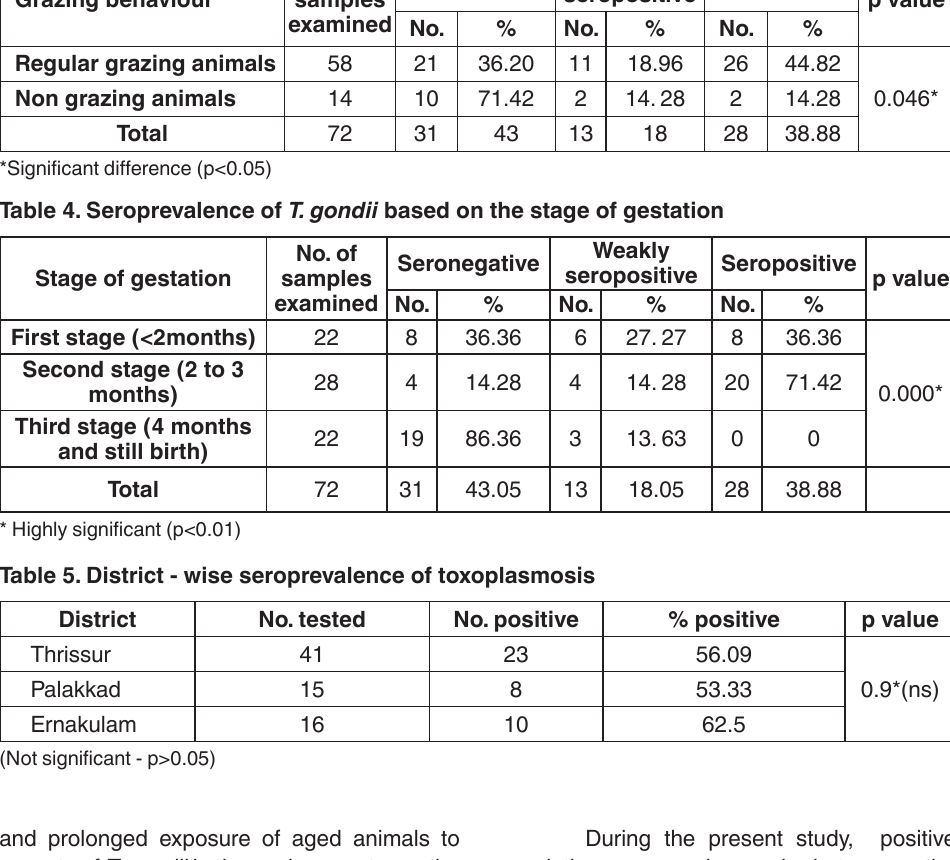
No. of samples examined